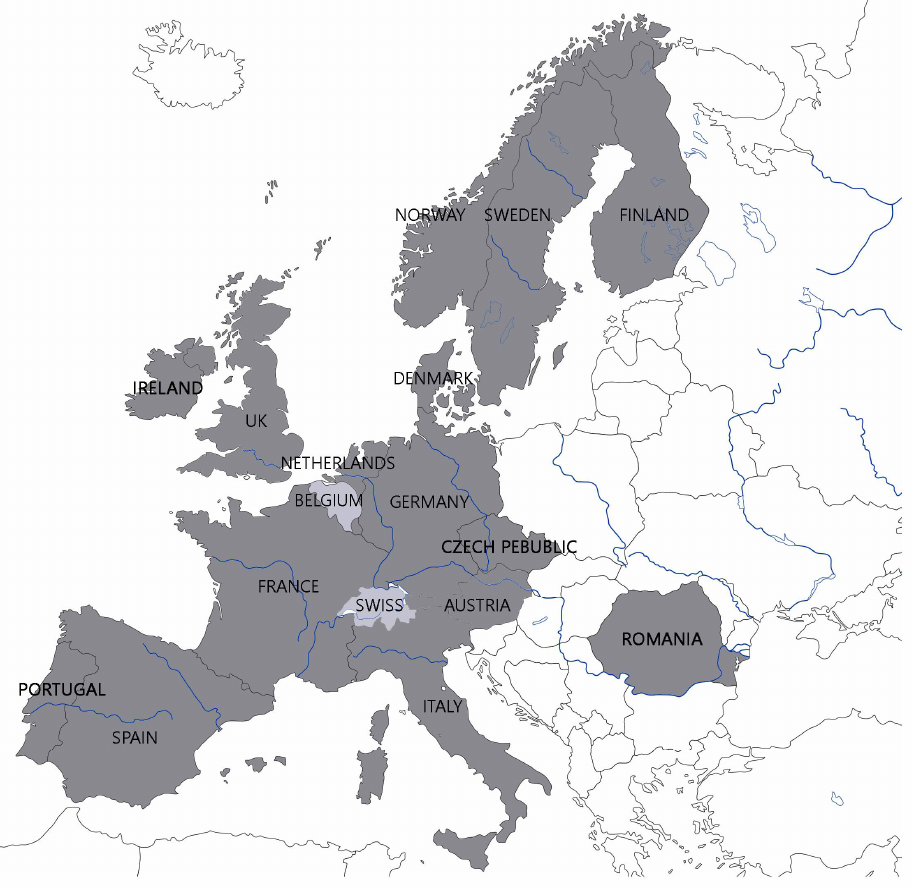
Figure 4. After 2014 to 2022: in dark gray, the European States that have a regulation on BIM; in light gray, the European States that have guidelines.